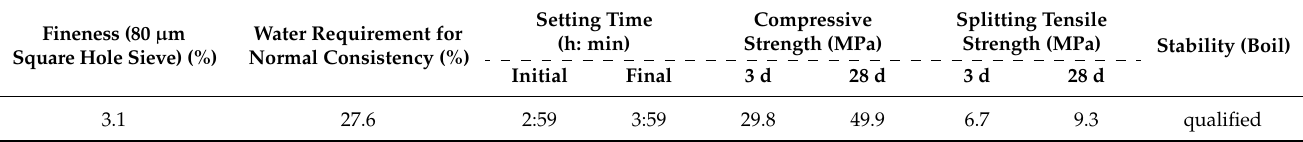
Table 5. The properties of cement.